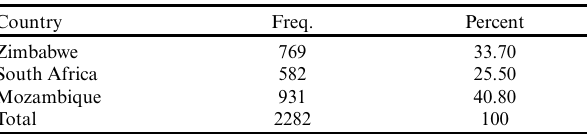
Table 2 . Sample size. Country Freq.